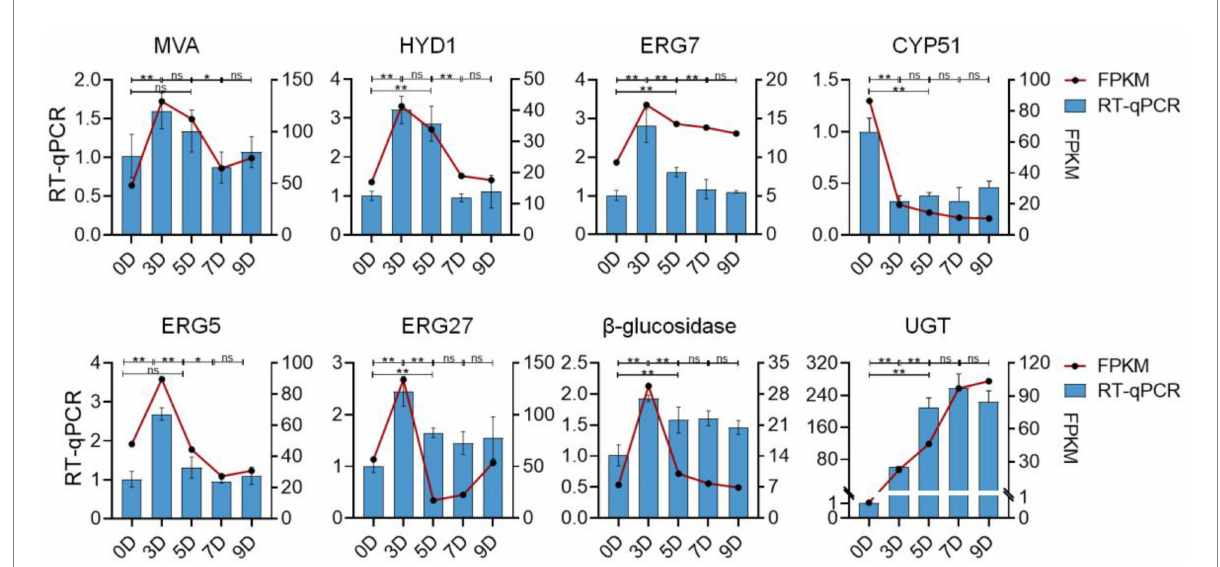
FIGURE 13 The expression profiles of qRT-PCR and RNA-seq of eight selected genes. The left vertical axis represents the relative expression of the gene based on qRT-PCR. The right vertical axis represents the expression level of the gene based on qRT-PCR. Values are means ± SD. The asterisk above the bar chart denoted statistical significance (* p < 0.05, ** p < 0.01, and ns p >